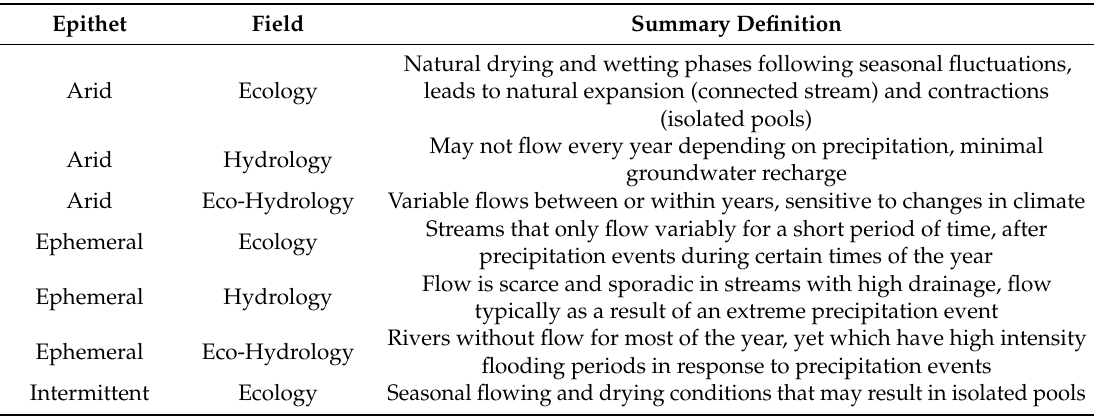
Table 3. Summary definitions for arid, ephemeral, intermittent, non-perennial, and temporary by broad research fields. Each one of these five epithets had over 80% of their papers provide a definition.